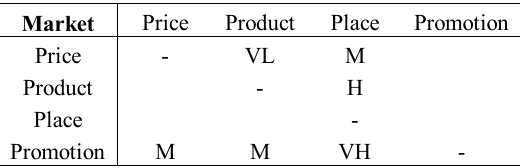
Table3. Pairwise comparisons of alternatives with respect to Company.